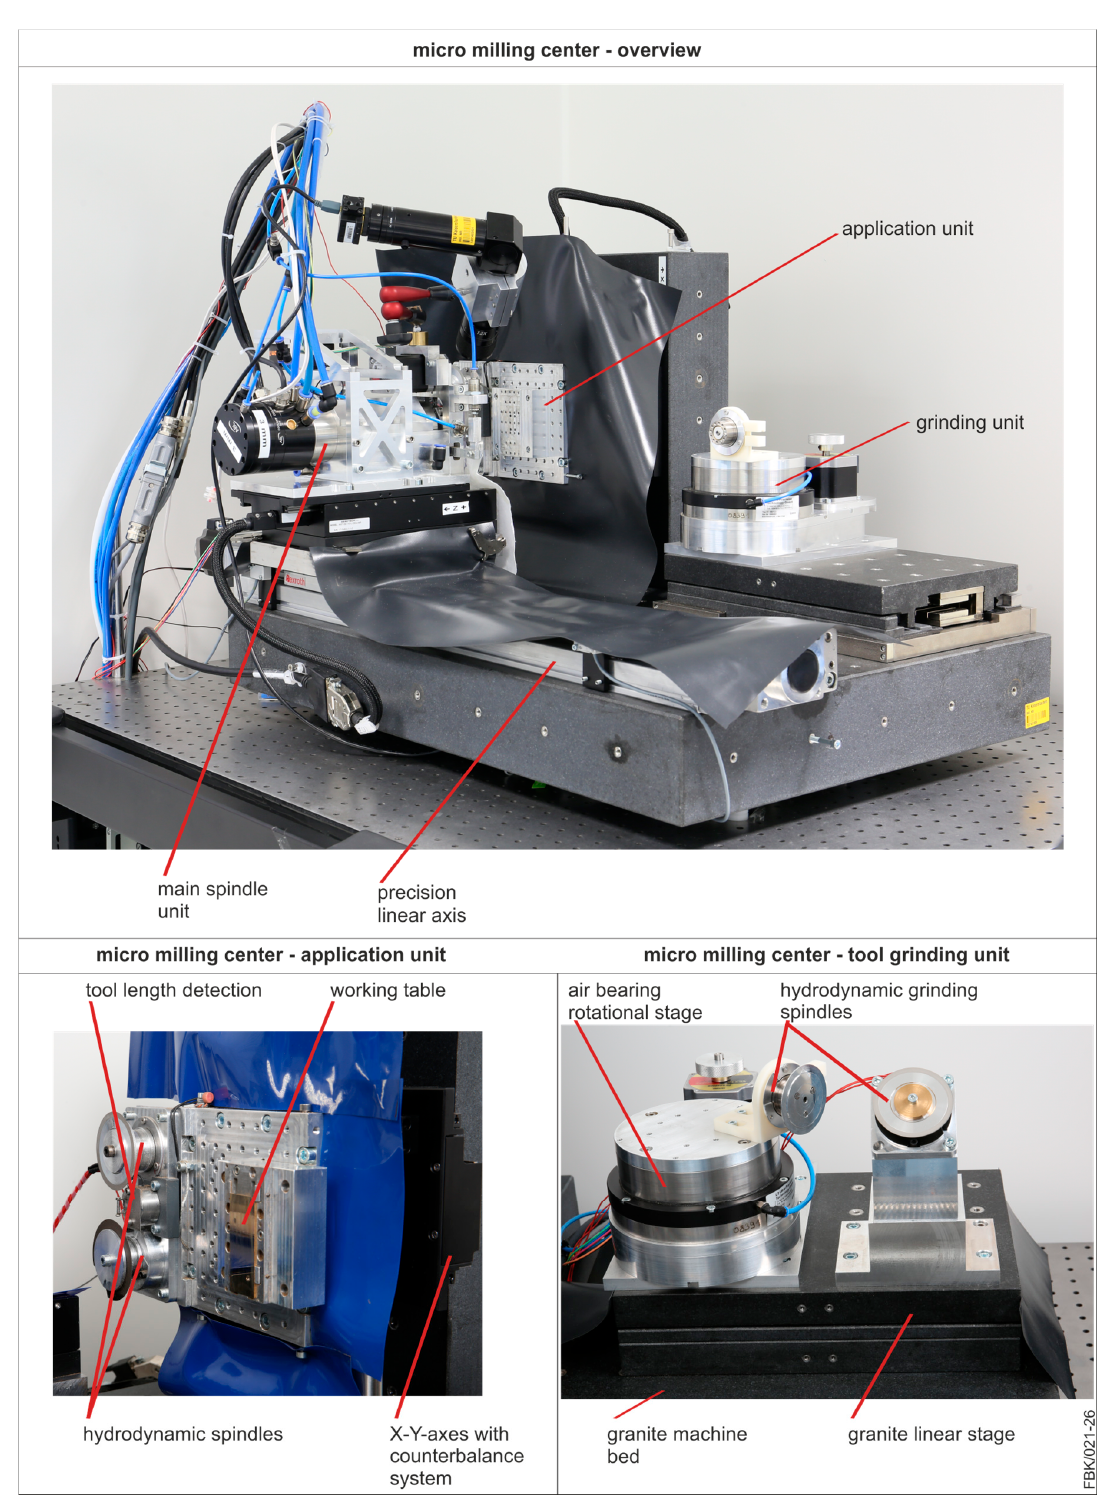
Figure 1. Micro milling center (MMC) after [18].